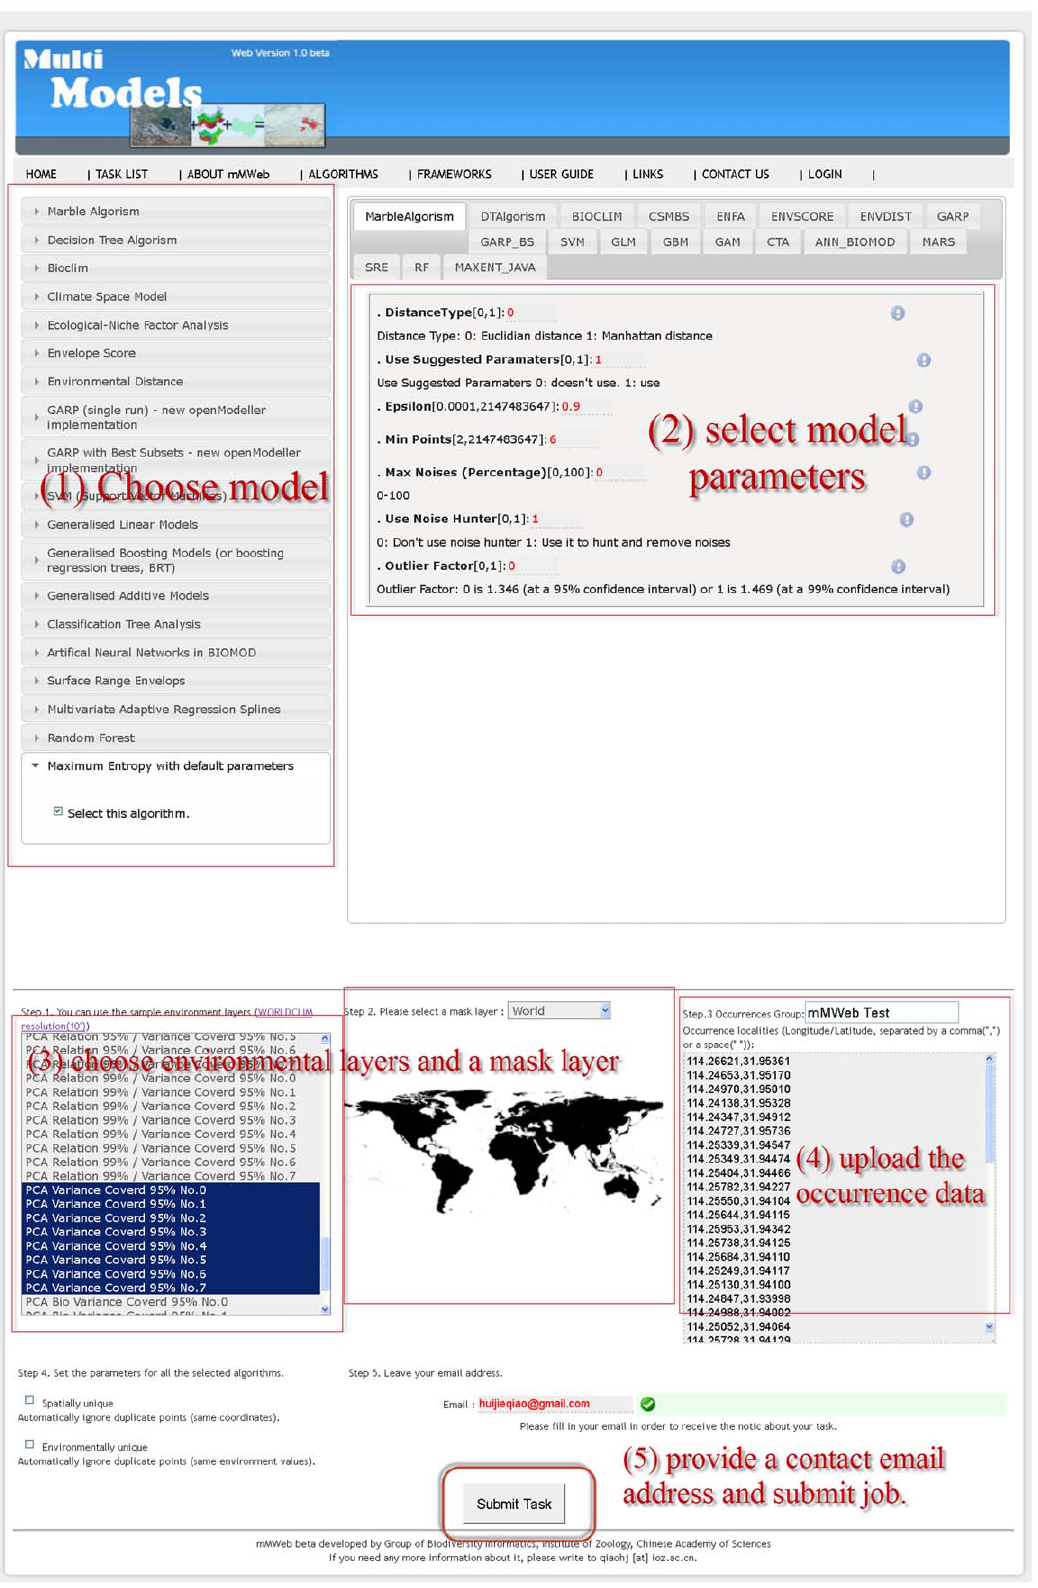
Figure 3. The steps to create and submit a task. 1) Choose model, 2) select model parameters, 3) choose environmental layers and a mask layer, 4) upload the occurrence data, 5) provide a contact email address and submit job.